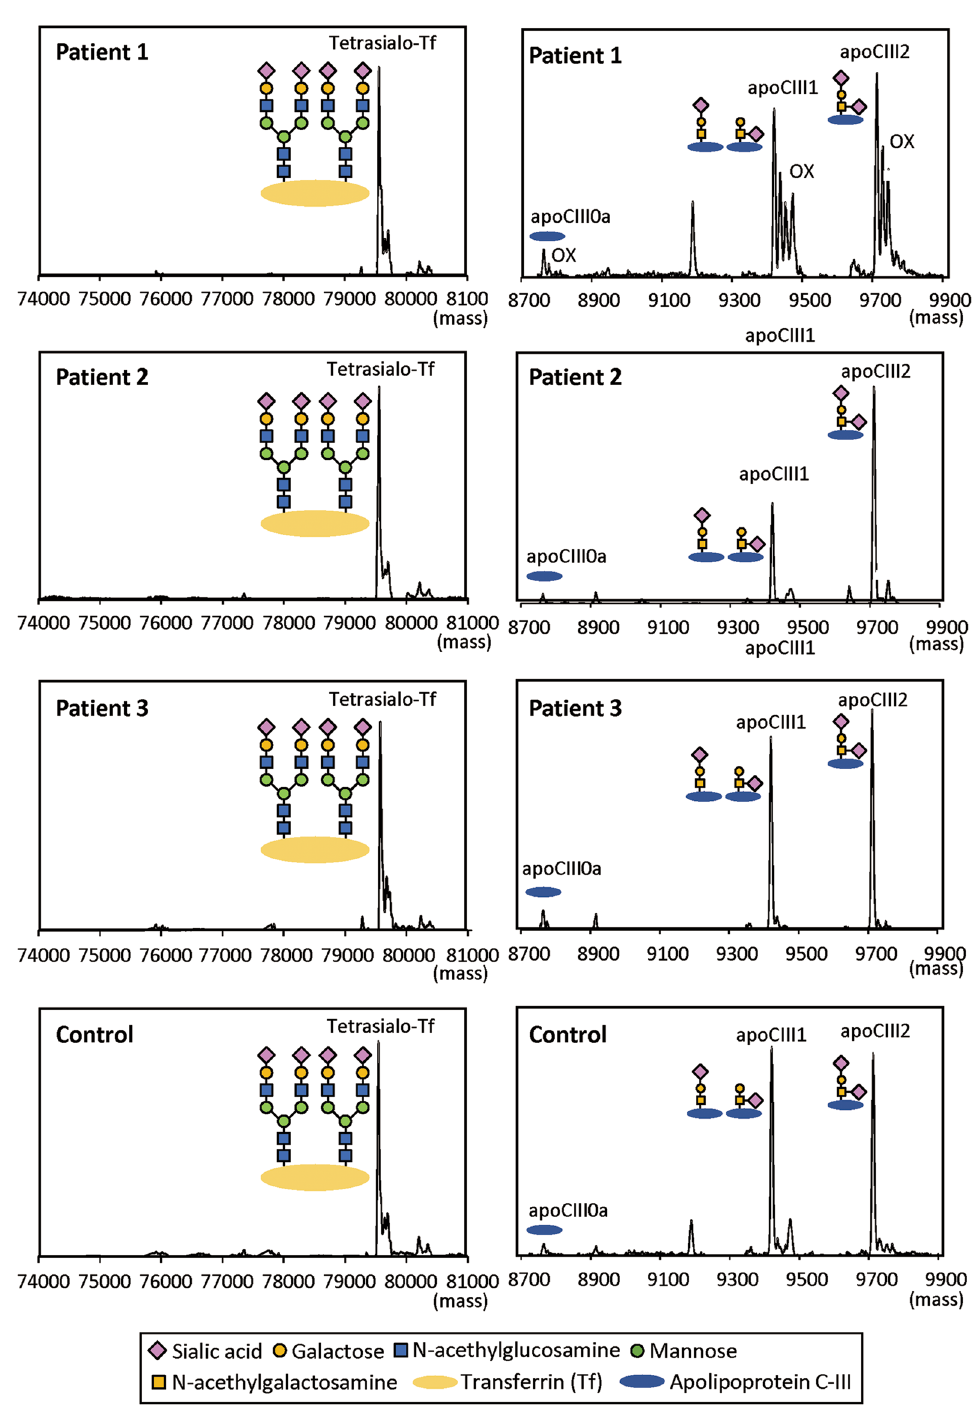
Figure 3. Glycosylation status of serum proteins in patients 1–3 and a control subject. The N -glycosylation status of transferrin (left) and the O -glycosylation status of apolipoprotein C-III (right) are normal in patients 1–3. Since the O -glycosylation status of apolipoprotein C-III in patient 1 was examined using serum sample stored at − 20 °C for 6 months, additional peaks due to oxidation of the core protein backbone (OX) are delineated. Other measurements were performed using fresh serum